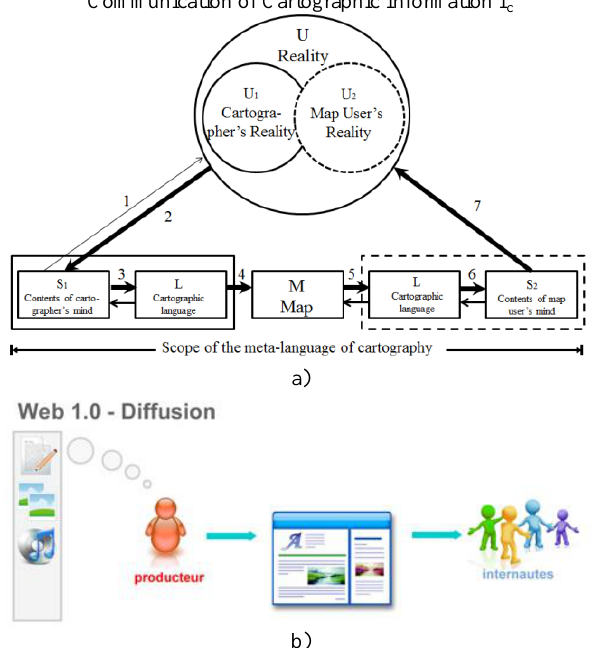
Figure 1. Concepts in EA/AtIS CoFr: (a) - «classical type», (b) - «Web